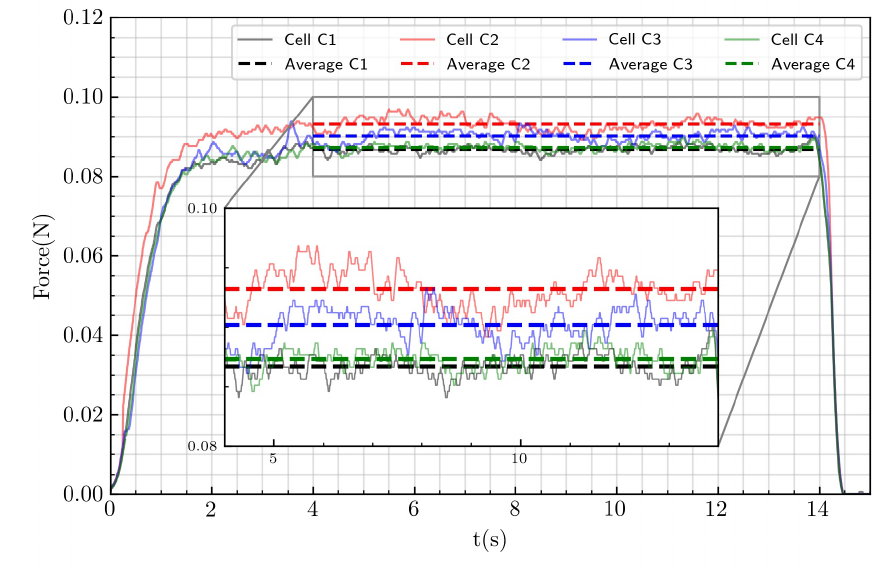
Figure 4. Example of the time series of force measurements in a typical experiment. In the example, the measurements of four load cells mean that it is an experiment for the normal drag